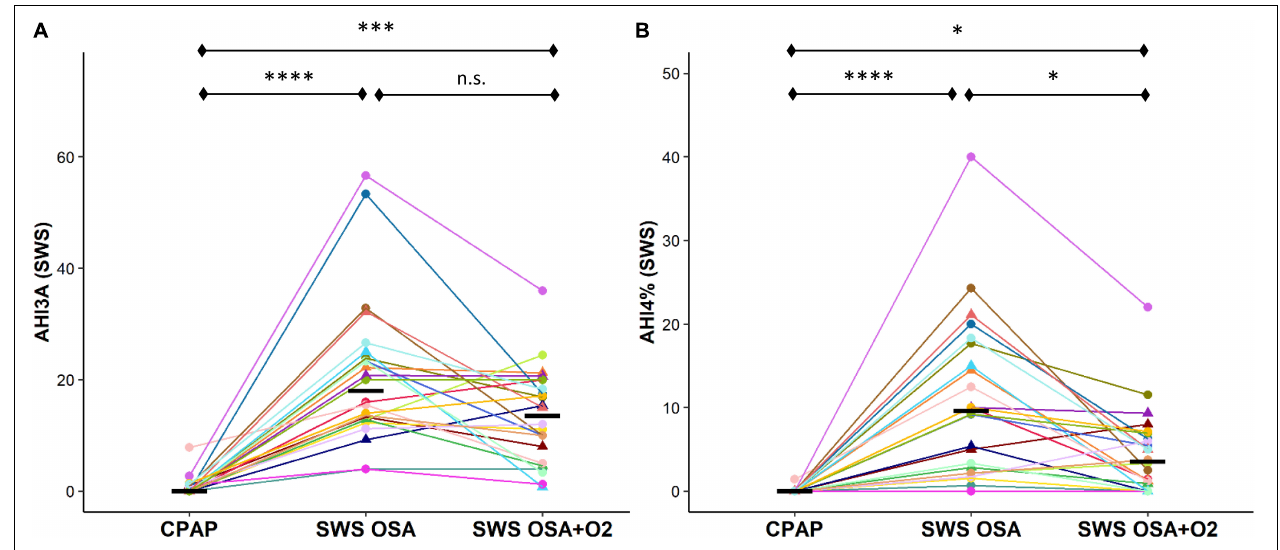
FIGURE 4 | Intermittent withdrawal of CPAP therapy during SWS results in an increase in OSA severity measures. OSA severity during SWS, as measured by AHI3A (A) and AHI4% (B) , was significantly greater during OSA SWS and OSA SWS + O2 conditions compared to CPAP. All 24 participants are represented by different colors with a triangle indicating female. Median values for each condition are shown as a solid black line. i.e. n.s., not significant; **** p < 0.0001, *** p < 0.001, ** p < 0.01 and * p <